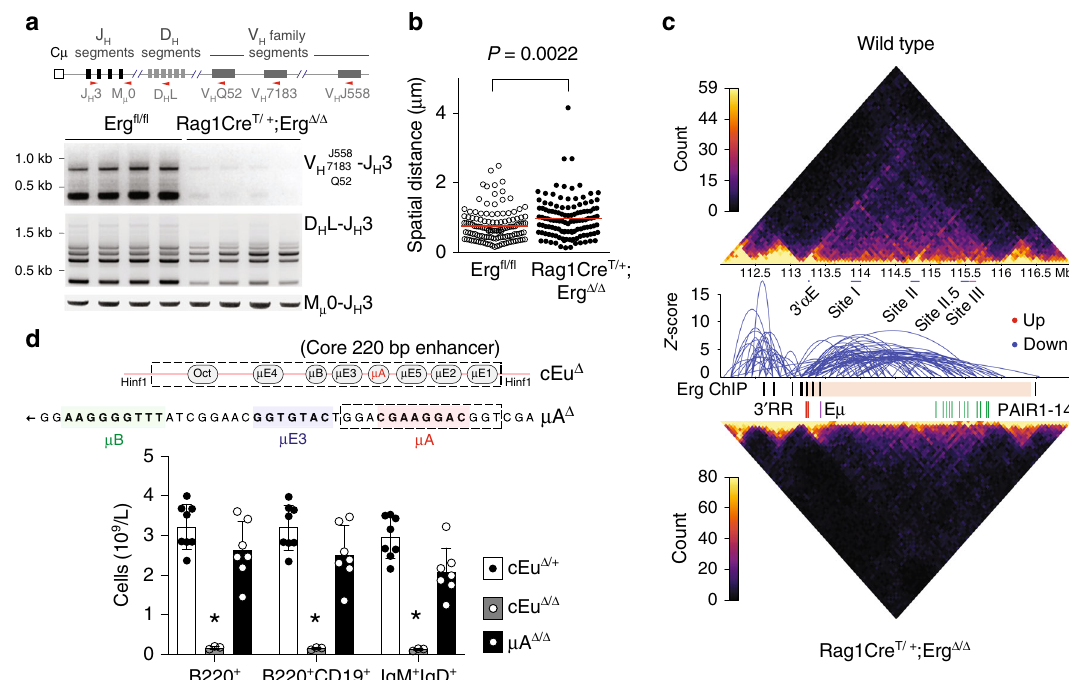
Fig. 2 The immunoglobulin heavy chain locus in Rag1Cre T/ + ;Erg Δ / Δ mice. a Genomic PCR using degenerate primers (approximate locations indicated by red arrowheads) to Igh locus V H J558, V H 7183, V H Q52 segments for detection of V H to DJ H (top panel) and D H to J H (middle panel) recombination with Mu0 loading controls (bottom panel) in B220 + BM cells. Representative of three independent experiments. b Intra-chromosomal distance between distal V H J558 and proximal V H 7183 V H families by fl uorescent in situ hybridisation from ( n = 129) Igh alleles from Erg fl / fl and Rag1Cre T/ + ; Erg Δ / Δ proB cells and pre – proB cells, respectively. P value by the Student ’ s two-tailed unpaired t test. c Differential long-range chromatin interactions identi fi ed by high- throughput chromatin conformation capture analysis (in situ Hi-C) of the Igh locus between C57BL6 (wild-type) proB cells and Rag1Cre T/ + ; Erg Δ / Δ pre – proB cells with interaction counts across the Igh locus shown. Reduced long-range interactions in Rag1Cre T/ + ;Erg Δ / Δ B-cell progenitors are indicated by blue arcs. Erg binding by ChIP (black bars) across the heavy chain locus (pink shading) as indicated. The location of 3 ′ regulatory region (3 ′ RR, red bars), iE μ enhancer (E μ , purple bar) and PAIR domains (green bars) are indicated. d Schematic representation of iE μ enhancer with the core 220 bp cE μ Δ deletion and μ A Δ deletion shown (top). Peripheral blood counts of B220 + , B220 + CD19 + and IgM + IgD + cells in cE μ Δ / + ( n = 8), cE μ Δ / Δ ( n = 3) and μ A Δ / Δ ( n = 7) mice (bottom). * P adj value 2.6e − 5 (B220 + ), 1.8e − 5 (B220 + CD19 + ) and 9.0e − 6 (IgM + IgD + ) by the Student ’ s two-tailed unpaired t test comparing cE μ Δ / Δ to cE μ Δ / + controls with the Benjamini Hochberg correction for multiple testing. Source data are provided in the Source data fi